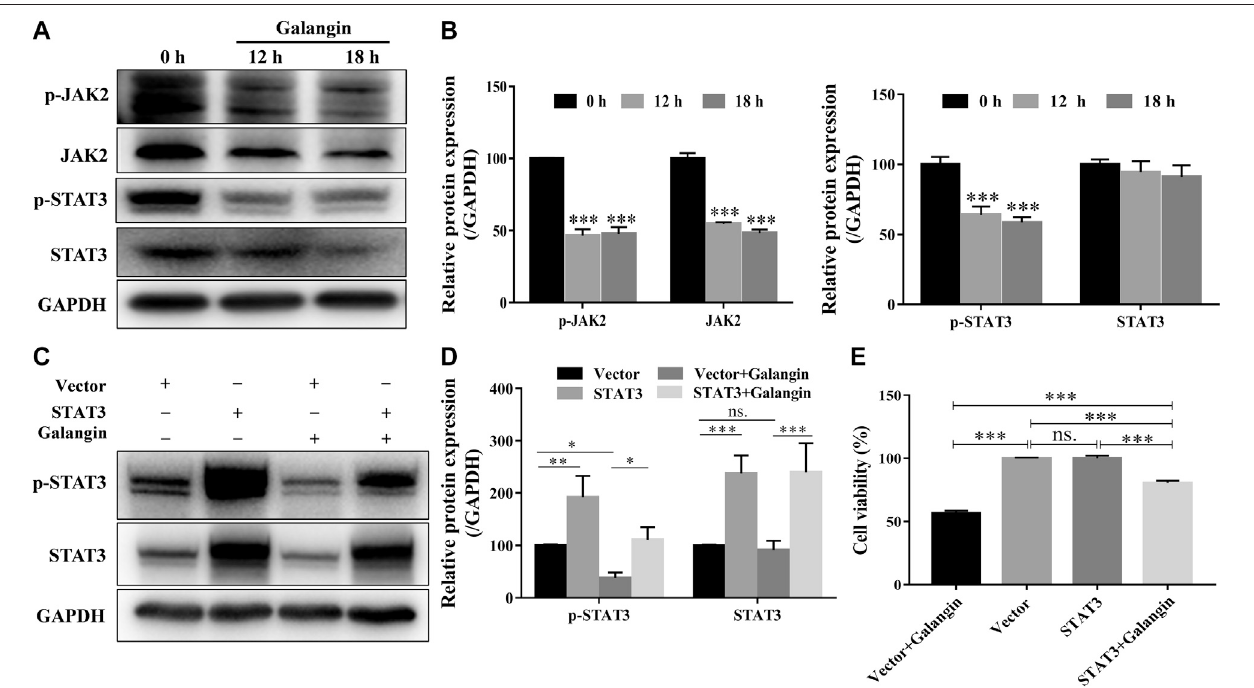
FIGURE 4 | Galangin inhibits overactivation of JAK2/STAT3 signaling pathway. (A – B) Galangin (20 μ M) decreased protein expression of JAK2, p-JAK2, STAT3, and p-STAT3 in MGC 803 cells after treatment for 12 and 18 h. (C – D) Overexpression of STAT3 reversed the inhibitory effect of galangin (20 μ M) on the protein expression of p-STAT3 and STAT3 in MGC 803 cells after treatment for 48 h. (E) Overexpression of STAT3 reversed the inhibitory effect of galangin (20 μ M) on the cell viabilityofMGC803 cellsafter treatmentfor48 h. All ofthedatawereshown asmean ± SD, and differences among ≥ 3 groupswere analyzed viaone-wayANOVA withDunnetttest( Figure4B ,comparedwithcontrol(0 h)group)orTukeytest( Figures4D,E )byusingGraphPad7.0software;* p < 0.05;** p < 0.01;*** p < 0.001.n ≥ 3.